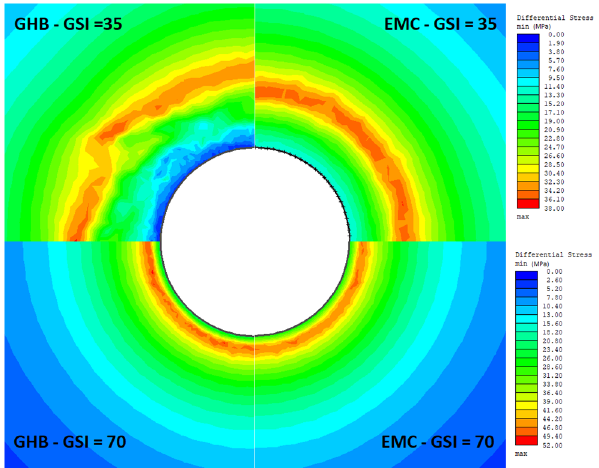
Figure 13. Distribution of the differential stress around the test tunnel for a major principal stress of